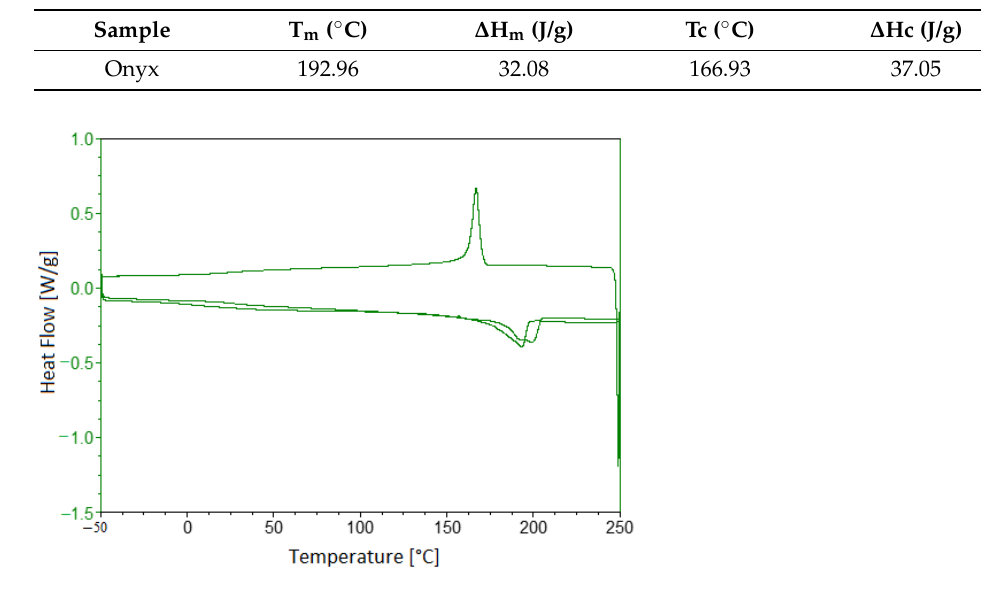
Figure 5. DSC results for Onyx sample.